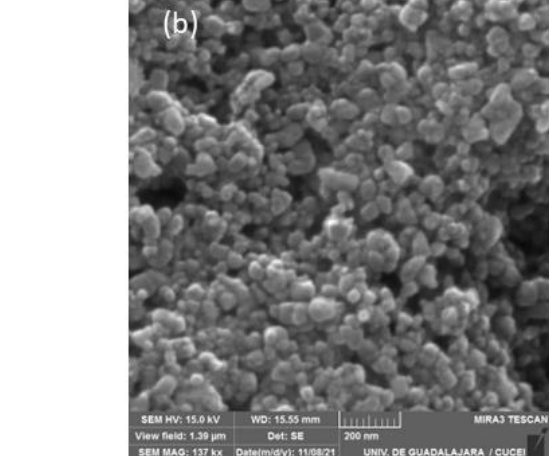
Figure 7. SEM micrographs of sample M11 at different magnifications ( a ) 500 nm and ( b ) 200 nm.